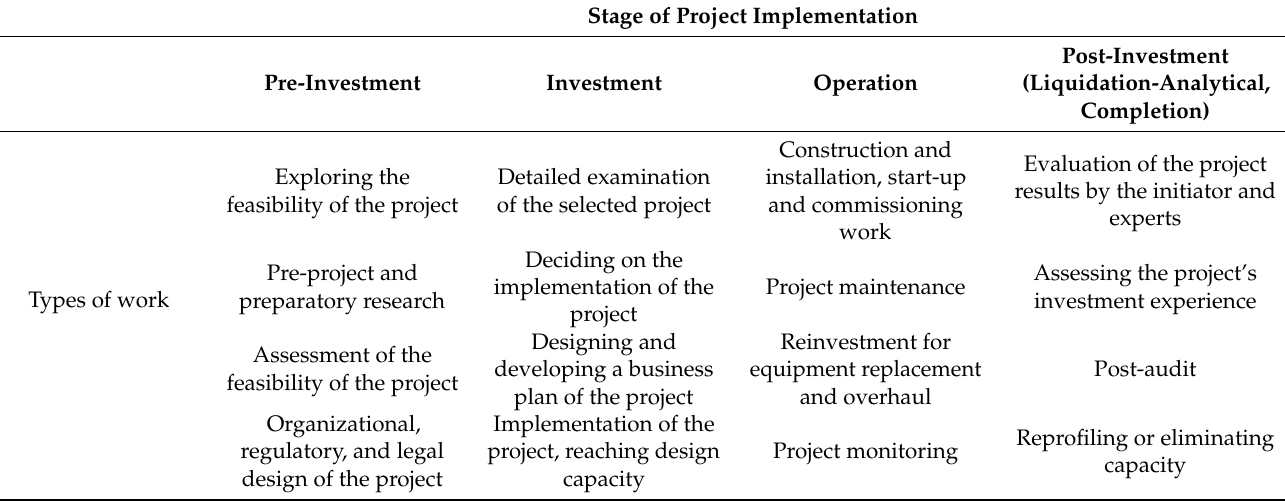
Table 3. Types of work at different stages of the PPP project implementation.